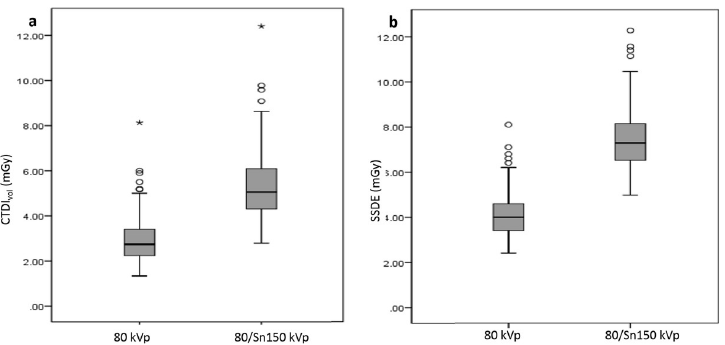
Fig 5. Box and whisker plots of CTDI vol (a) and SSDE (b) for 80 kVp and 80/Sn150 kVp scans. Box-and-whisker diagrams show mean values ± standard deviation, as well as minimum and maximum values.